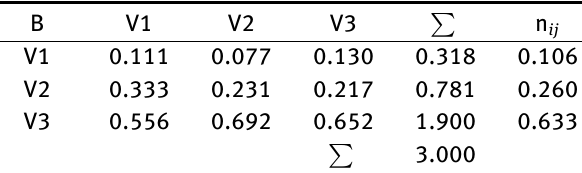
Table 9: Comparison of variants in accordance with deployment